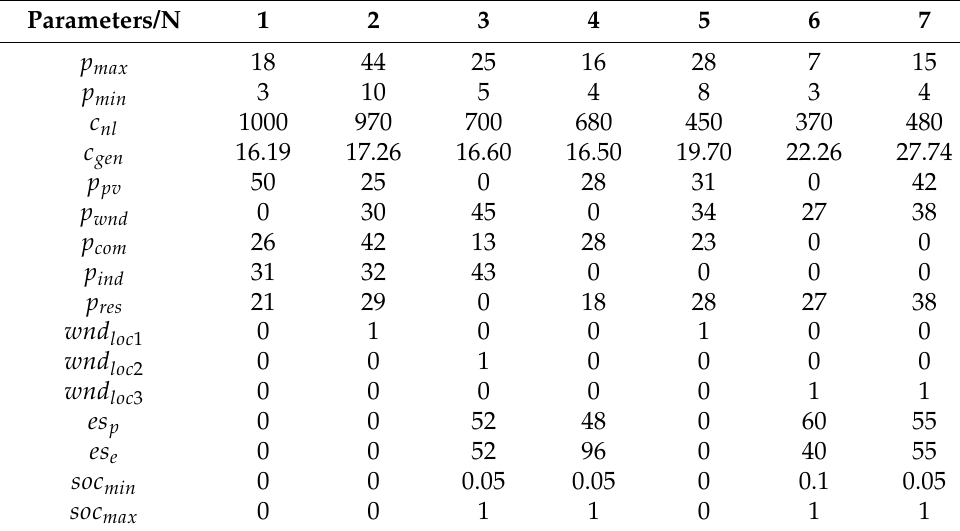
Table A9. Table representing the parameters in DS 2.